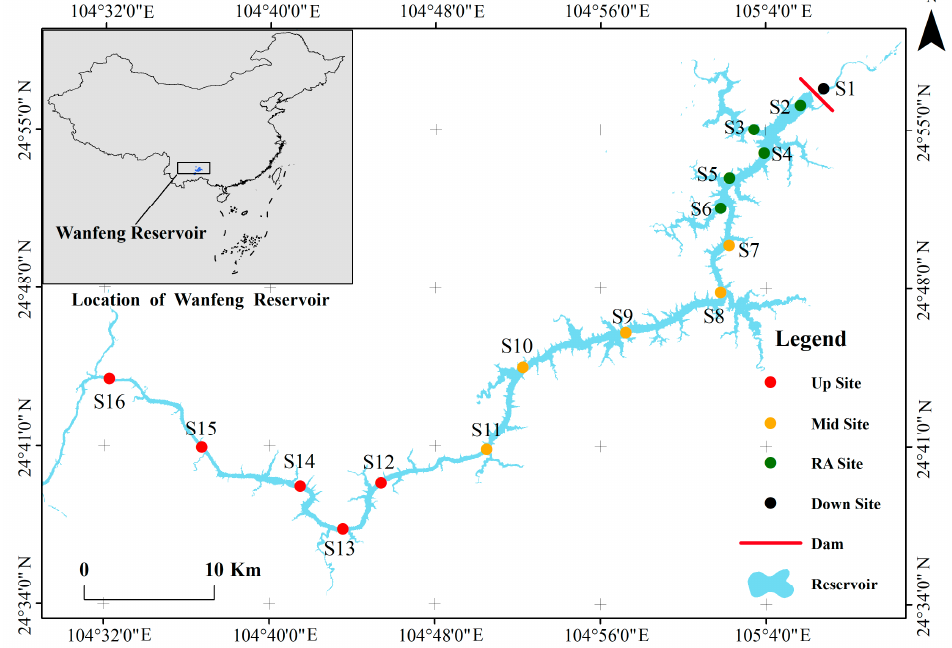
Figure 1. Map of sampling sites for eDNA sample collection at the Wanfeng Reservoir, with the geographical location of the Wanfeng Reservoir in China marked on the small map in the upper left corner. Different sections are distinguished by differently colored sampling points. Table 1. Records of latitude, longitude, and environmental